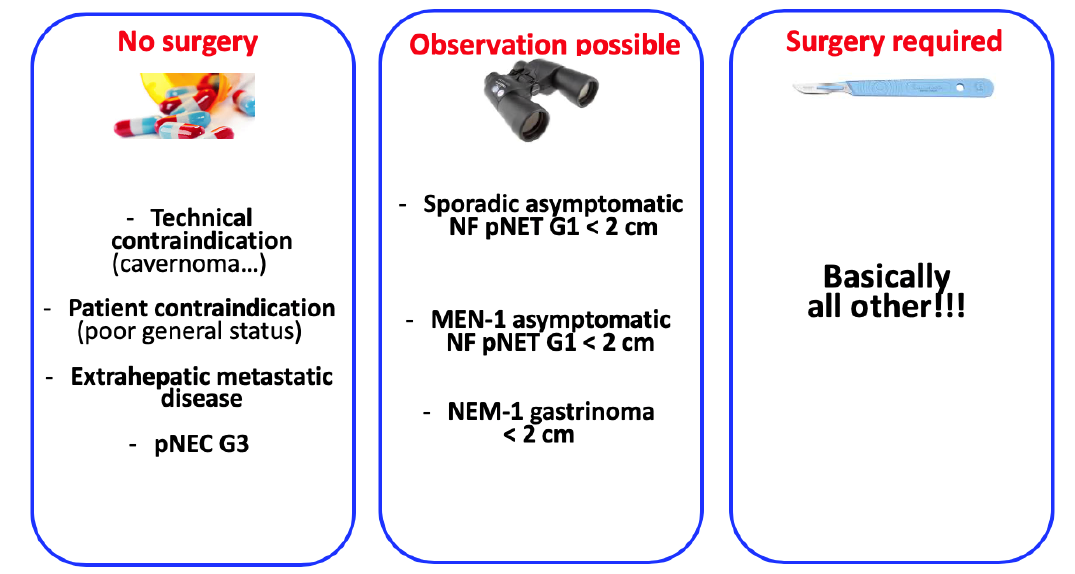
Figure 4. Description of the main surgical indications for pNETs.